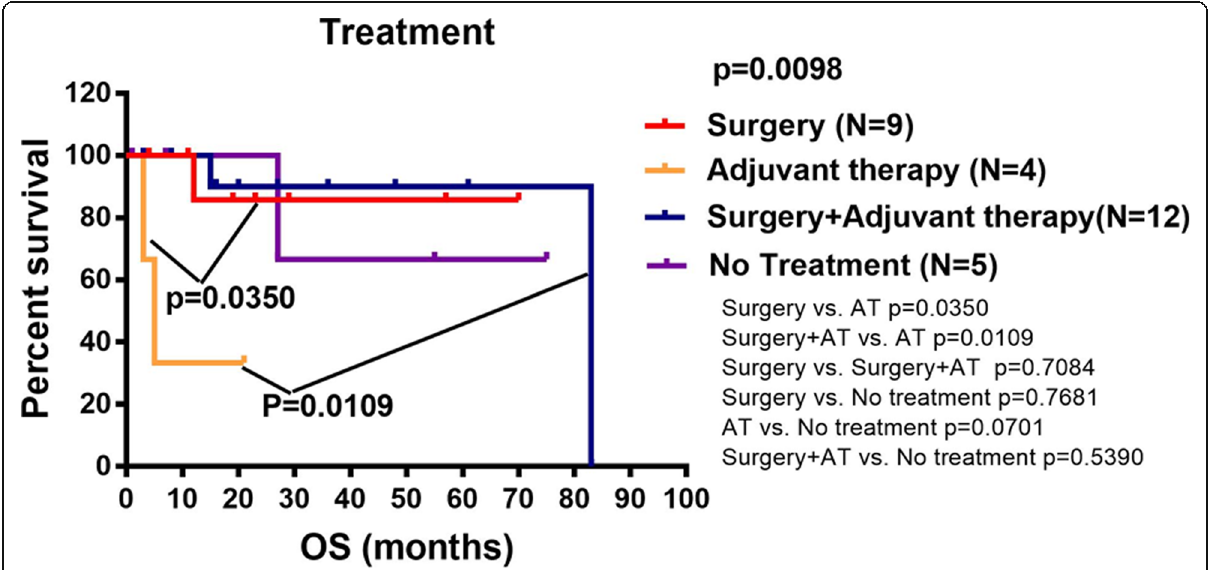
Fig. 6 Kaplan-Meier curves for overall survival based on different treatment